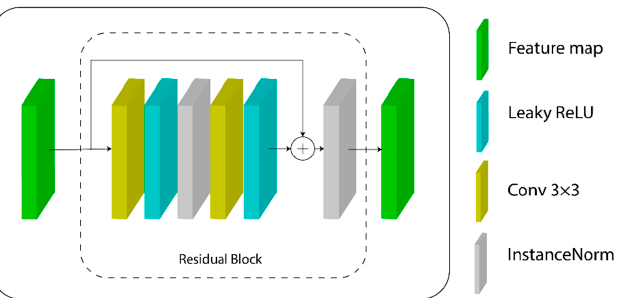
Figure 4. Architecture for the residual block within the second part of the generator model for the cGAN. A skip connection is used to preserve information from the block’s input feature map to the last layers, combining them as a sum